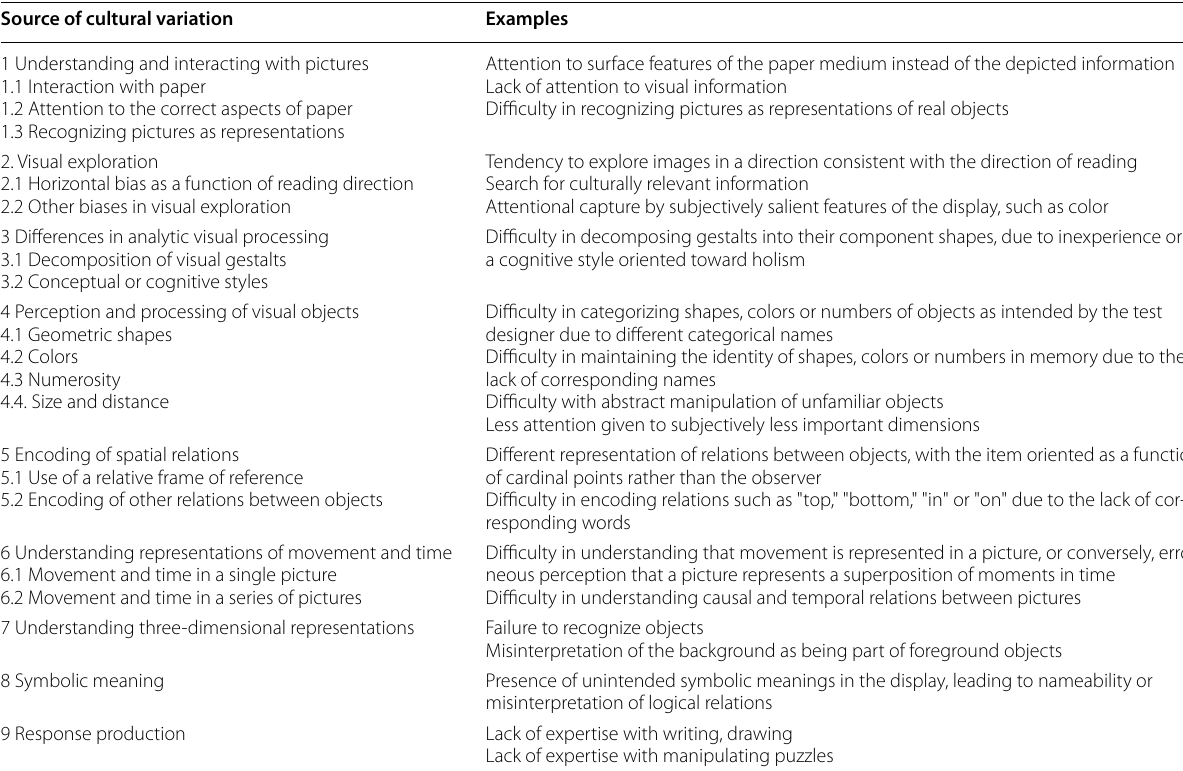
Table 1 Major sources of cultural differences in visuo-spatial processing applicable to visuo-spatial intelligence